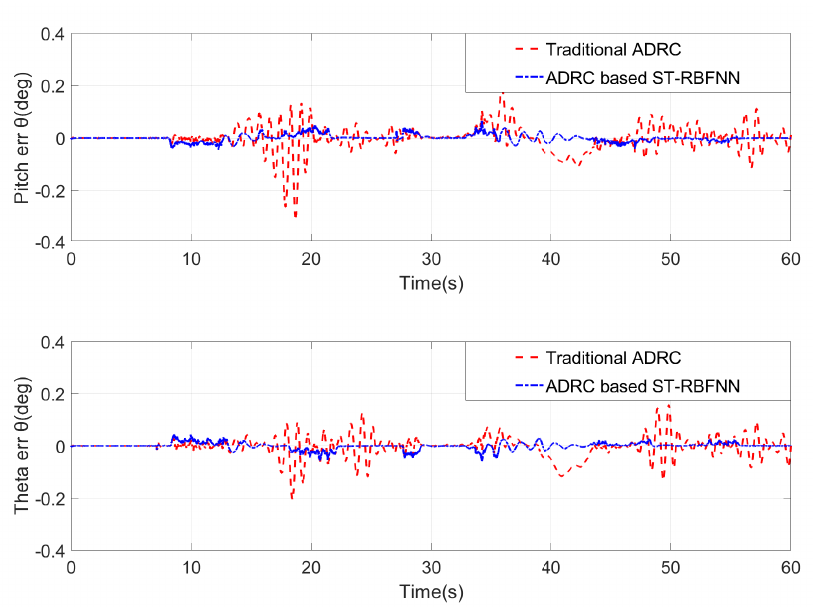
Figure 9. Flight attitude tracking error of quadrotor in Scenario 1.